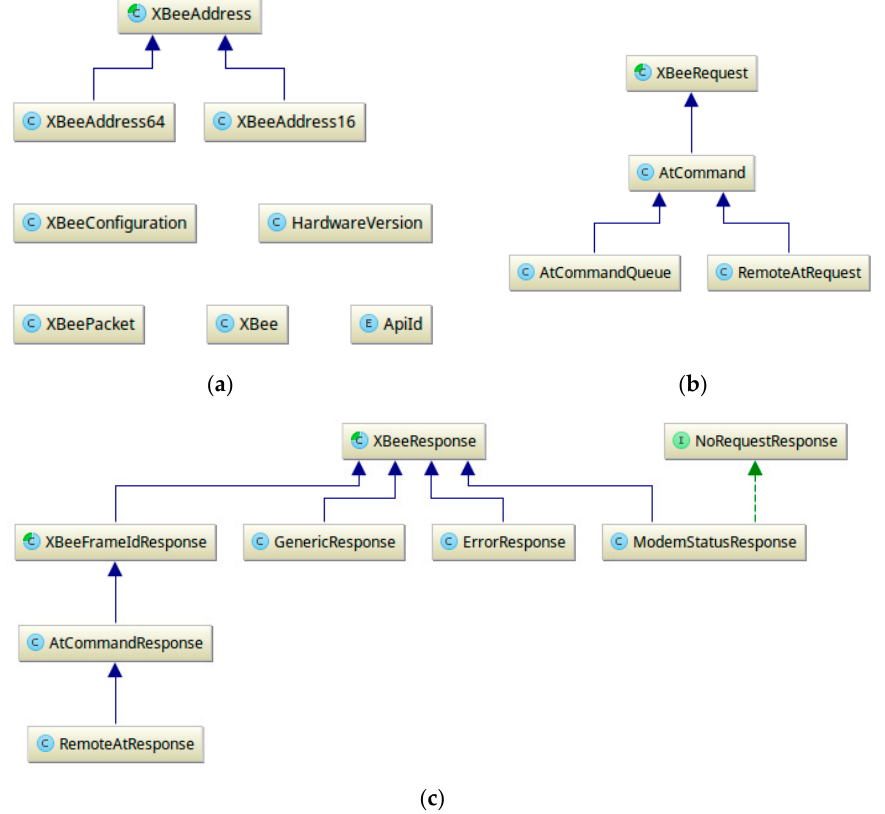
Figure 13. ( a ) Class hierarchy modelling the XBee according to the datasheet; ( b ) Class hierarchy modelling the XBee request according to the datasheet; ( c ) Class hierarchy modelling the XBee response according to the datasheet.